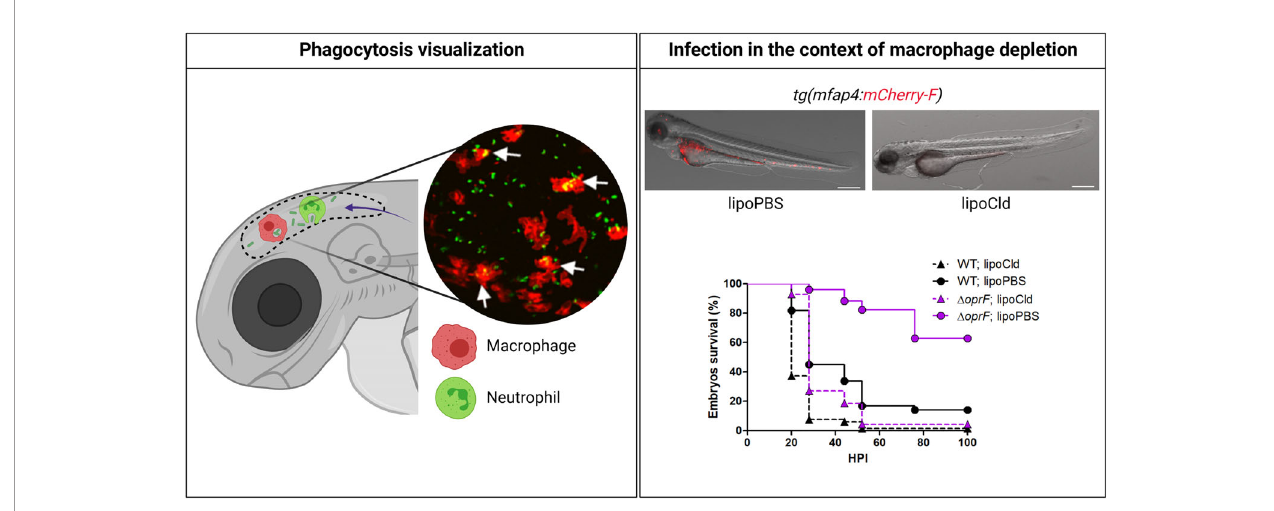
FIGURE 2 | Advantages of zebra fi sh embryo to assess in vivo the interplay of Pseudomonas aeruginosa with innate immune cells. As shown in the left panel, using speci fi c transgenic lines carrying fl uorescently labeled macrophages [e.g., tg(mfap4:mCherry-F) ] or neutrophils [e.g., tg(mpx:GFP) ], and thanks to the transparency of the embryo, migration of professional phagocytes toward infectious foci (here HBV) and phagocytosed bacteria can be visualized in real time. The inserted picture is a confocal microscopy image where macrophages express mCherry (red labeling), P. aeruginosa PAO1 expresses GFP (green labeling), and phagocytosed bacteria are indicated by arrows (Moussouni et al., 2021). To assess the respective involvement of macrophages and neutrophils upon P. aeruginosa infection, toxin-based (lipochlodronate, nitroreductase system) or genetic tools (morphants) are available to speci fi cally deplete one or the other cell population. In the right panel, images show the ef fi ciency of macrophage depletion by lipochlodronate (lipoCld) in tg(mfap4:mCherry-F) fi sh line (Moussouni et al., 2021). Survival curves of lipoCld-treated and non-treated embryos infected with PAO1 wild-type stain or PAO1 D oprF mutant are shown (Moussouni et al., 2021). Created with